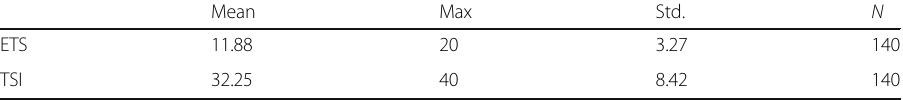
Table 9 Descriptive statistics for expected scores and underlying language abilities in academic environment in the TOEFL iBT test